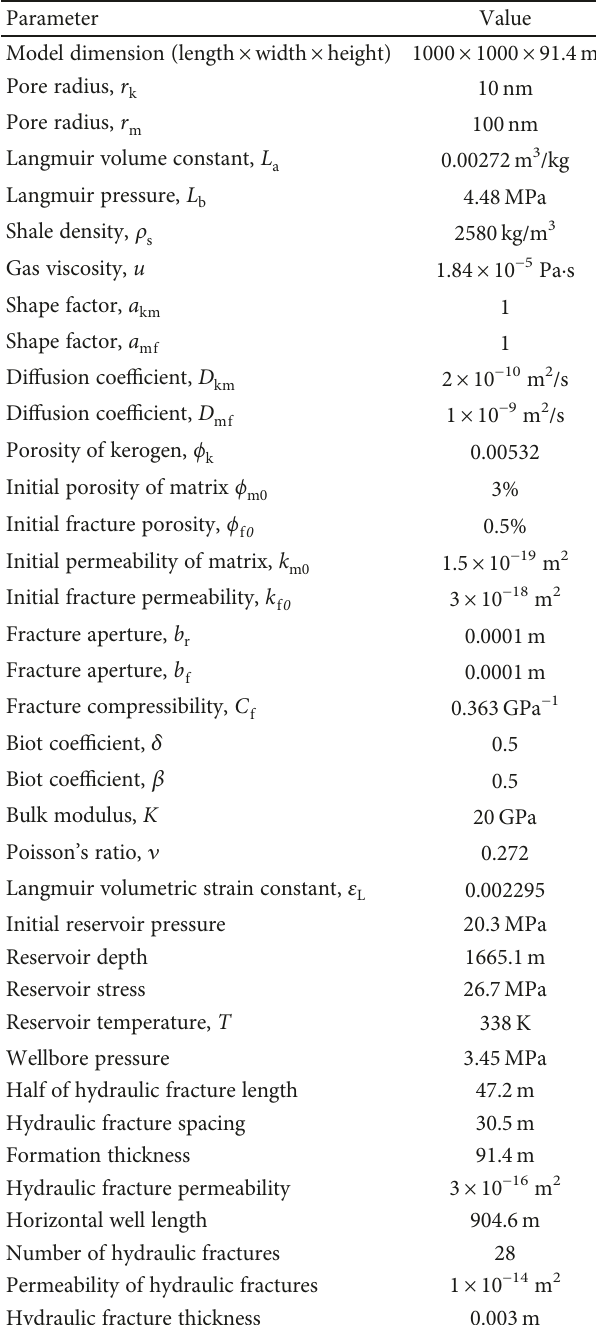
Table 1: Values of variables used for the